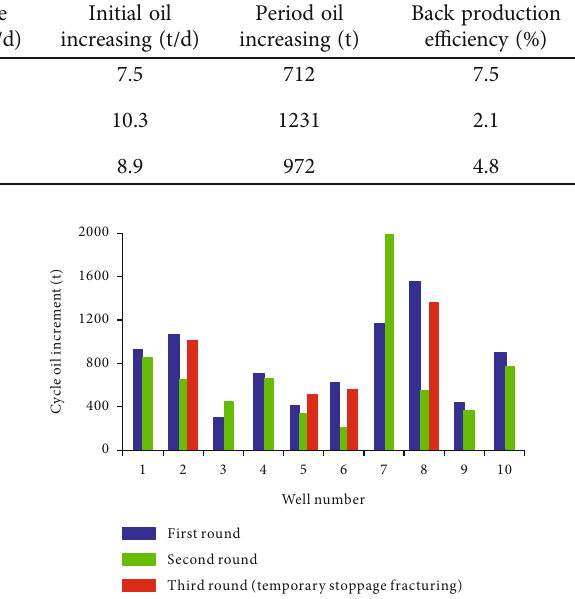
Figure 6: Cycle oil increment of water hu ff -pu ff in multirounds of 10